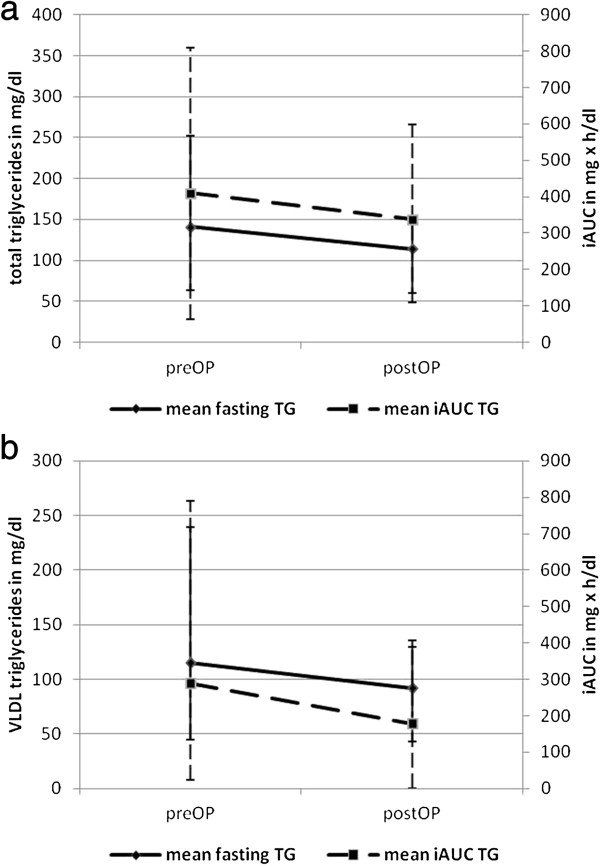
Mean values for fasting total (a) and VLDL (b) TGs and iAUC of total and VLDL TGs before and 3 months after sleeve gastrectomy (Mean + Maximum value/-Minimum value).